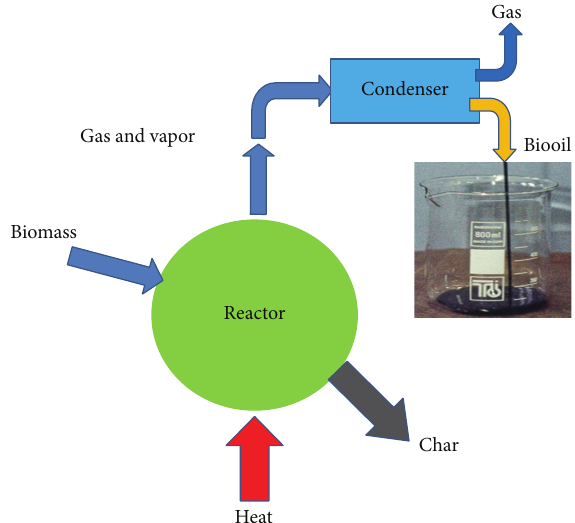
Figure 1: A possible pathway of pyrolysis of organic solid